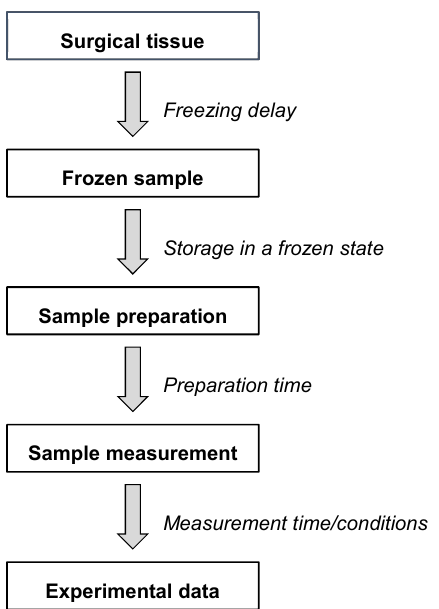
Figure 2. Different steps and time windows between the tissue sampling and the final HR-MAS NMR data.